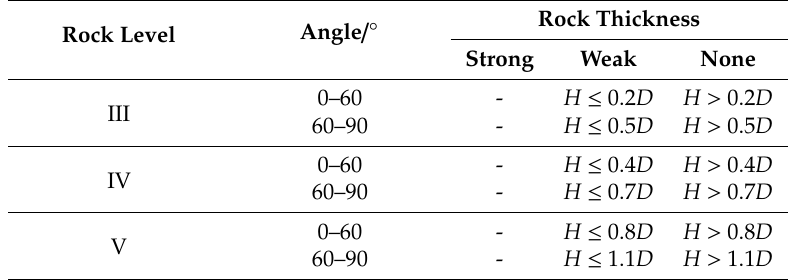
Table 10. Influence zoning of high-speed railway (HSR) cross tunnels for train speed = 250 km / h.